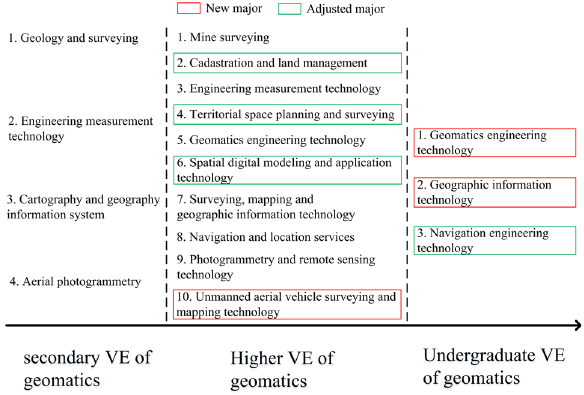
Figure 2. The newly revised discipline catalog in 2021